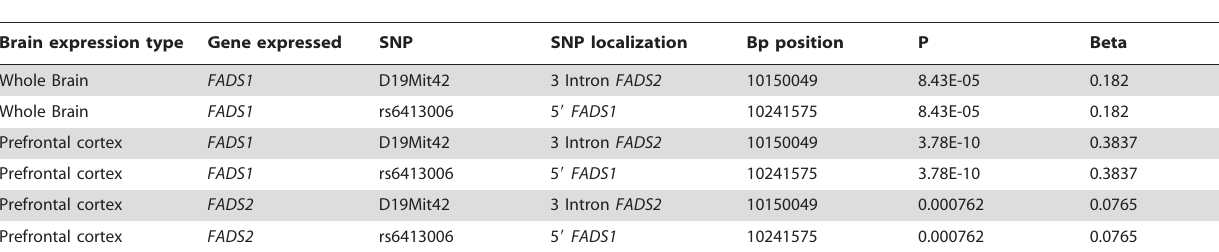
Table 5. List of FADS genetic variants significantly associated with FADS expression for each mice brain region ( P -values , 0.007).